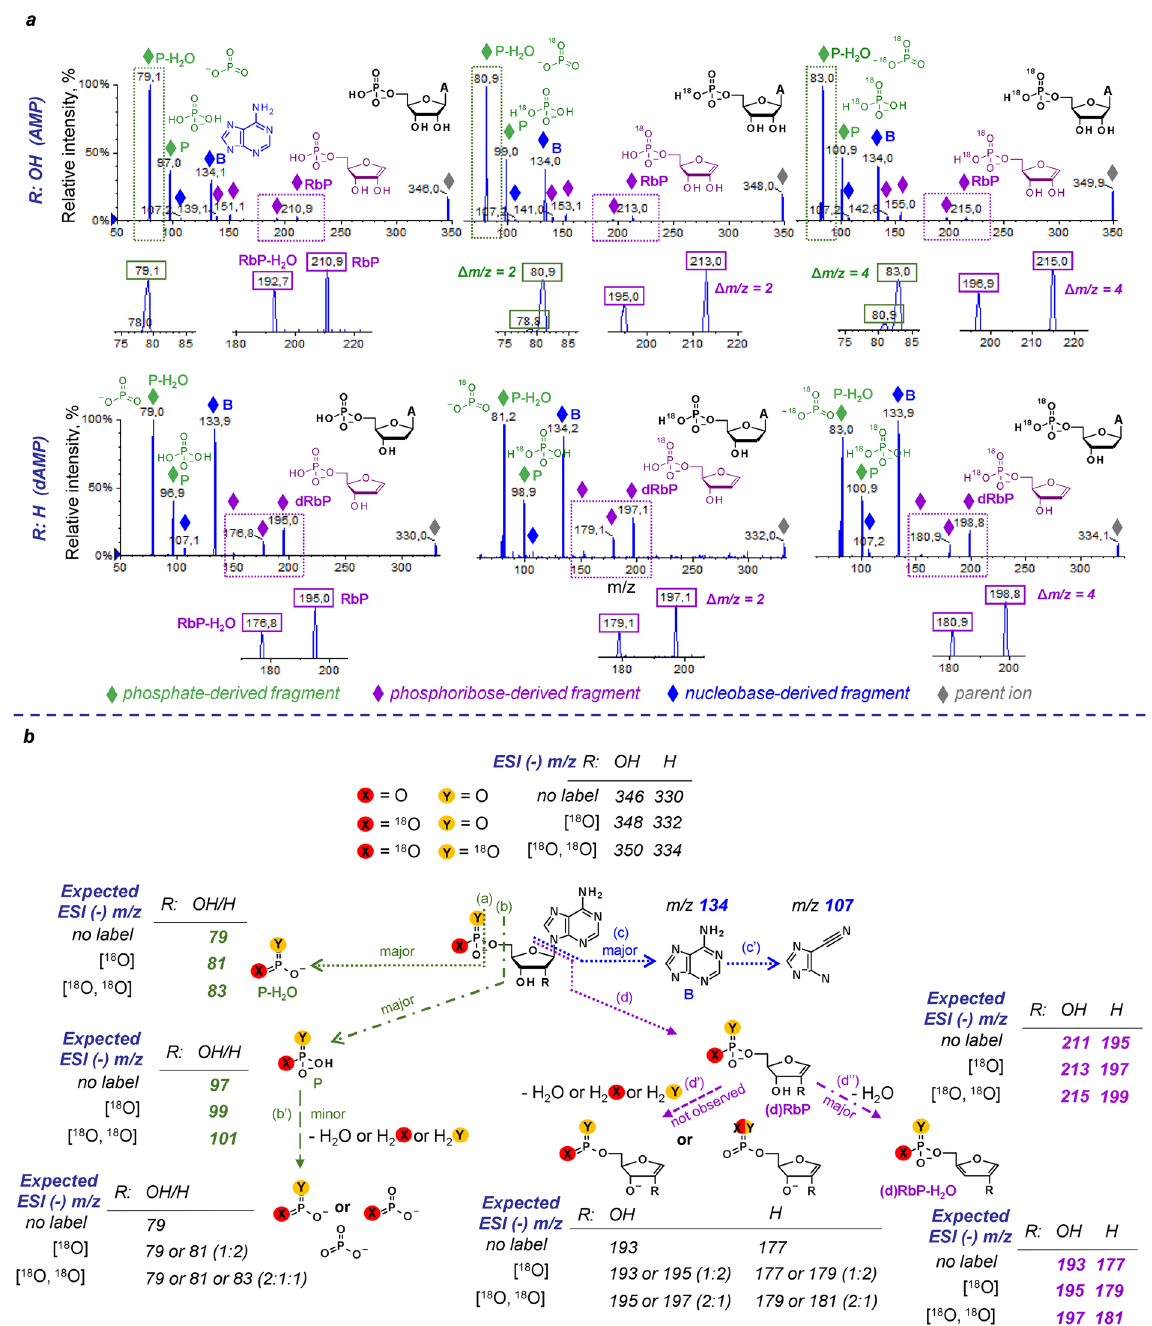
Figure 2. Negative-ion mode fragmentation of nucleoside 5 ′ -monophosphates (NMP). ( a ) MS/MS spectra of AMP and dAMP and their [ 18 O]-labelled analogues. Three types of fragments are visible in the spectra: nucleobase derived (marked with blue dots), phosphoribose-derived (purple dots), and phosphate- derived (green dots). Upon 18 O-isotopic labelling of phosphate moieties, the m/z values for phosphate- and phosphoribose-derived fragments that retain heavy water shift accordingly. ( b ) Fragmentation pathways for NMPs, exemplified by adenine nucleotides, proposed based on the interpretation of MS/MS spectra of nucleoside 5 ′ -monophosphates and their 18